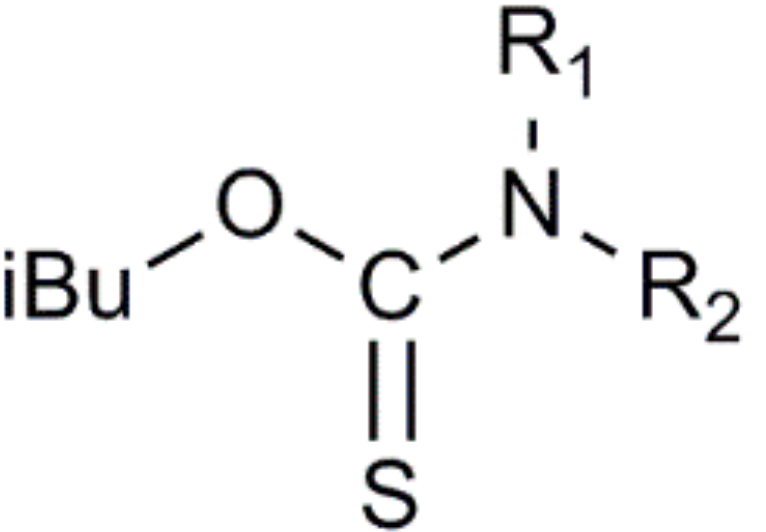
Figure 1. Structure of N -alkyl-, N , N -dialkyl-, and N -cycloalkyl- O -isobutyl thiocarbamate, where R1 is Et, Pr, iPr, Bu, iBu, secBu, iPen, cycPr, cycBu, cycPen, and cycHex, while R2 is H, Et, Pr, and Bu.